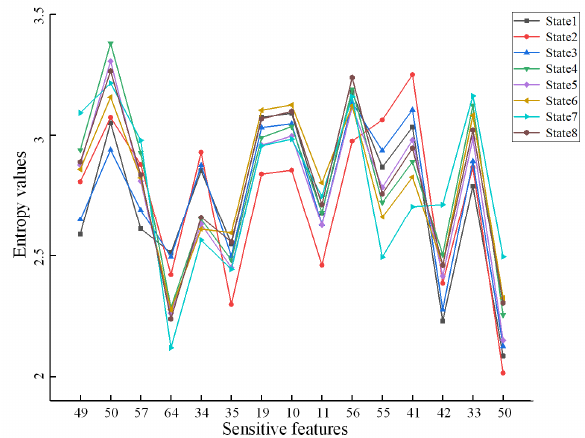
Figure 11. Sensitive fault features of different states.